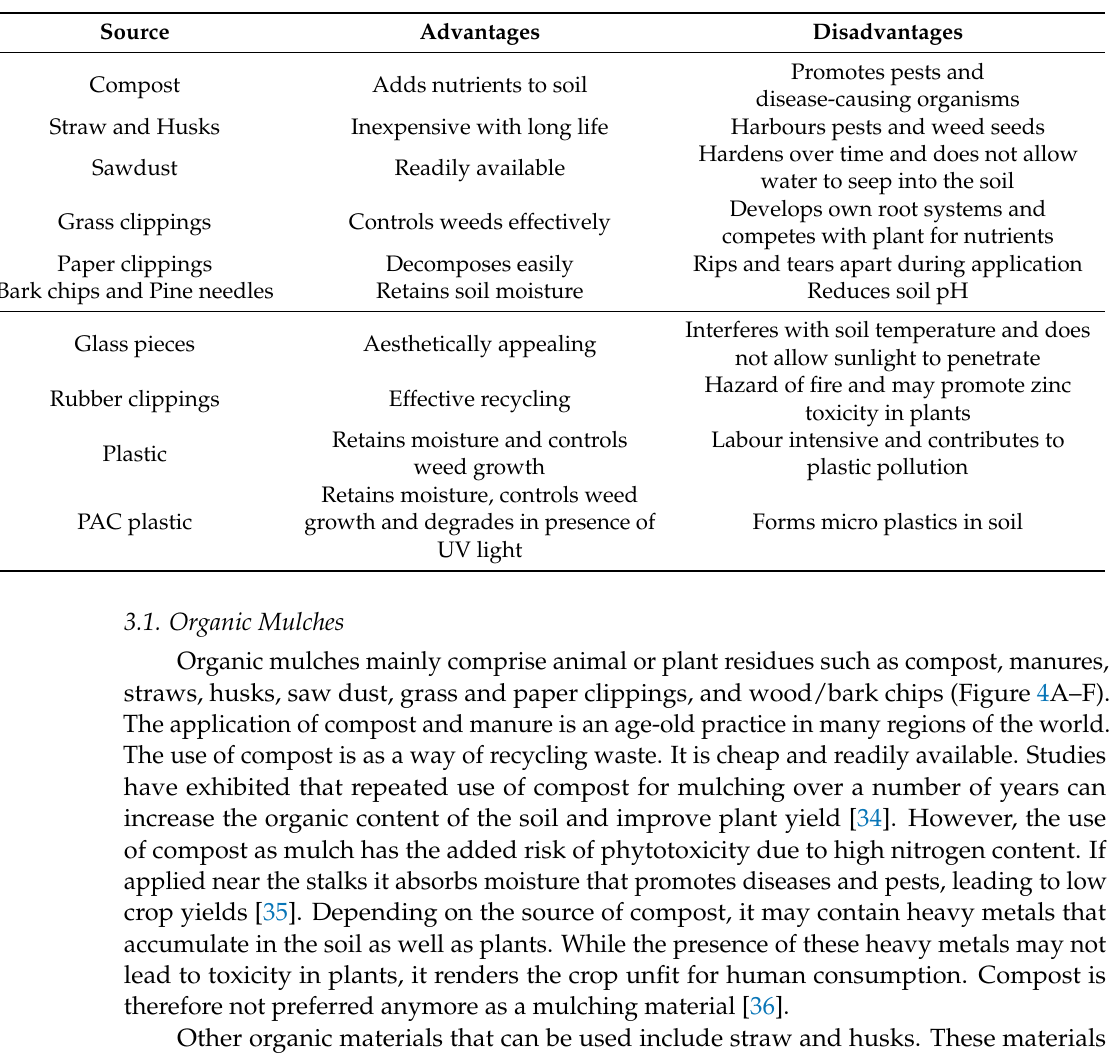
Table 1. Comparison of the sources, advantages and disadvantages of organic and synthetic mulch